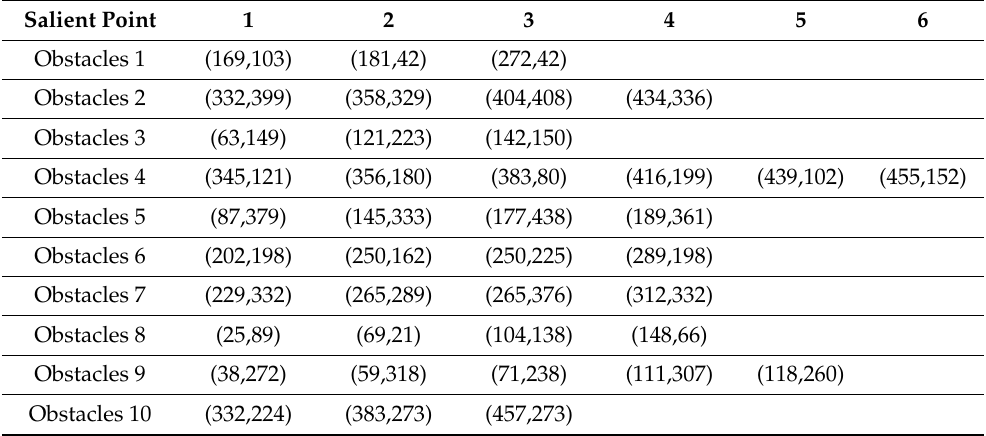
Table 5. Coordinates of salient points under the plane with dense obstacles